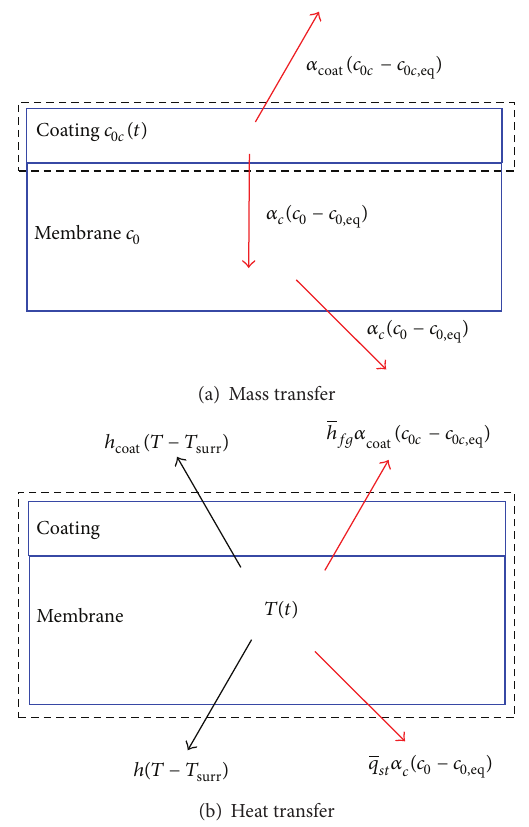
Figure 7: Fluxes used in heat and mass transfer when coating is